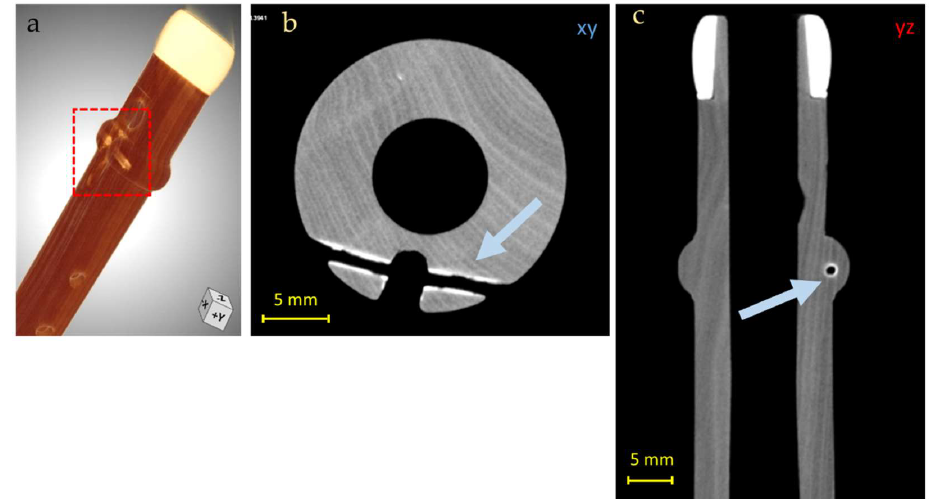
Figure 7. 3D render of the Piccolo Flute foot ( a ) and CT horizontal ( b ) and lateral ( c ) slices of the Piccolo Flute foot, in which the supposed metallic residues from the brass key insertion is observed (blue arrows in ( b , c ) and red square in ( a )).